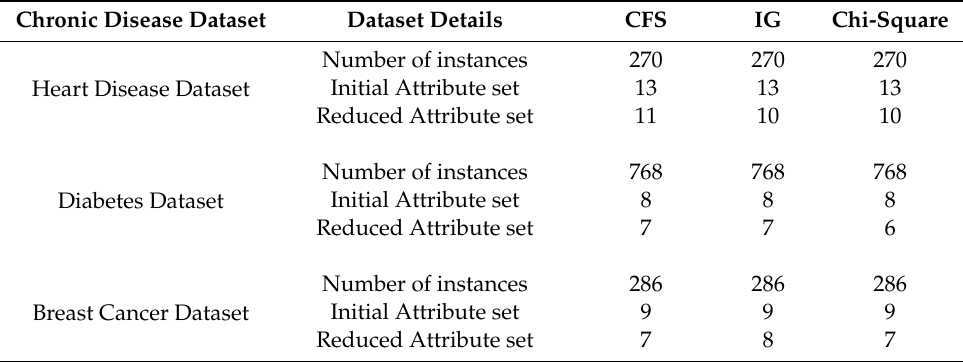
Table 8. Impact of filter methods on disease datasets.